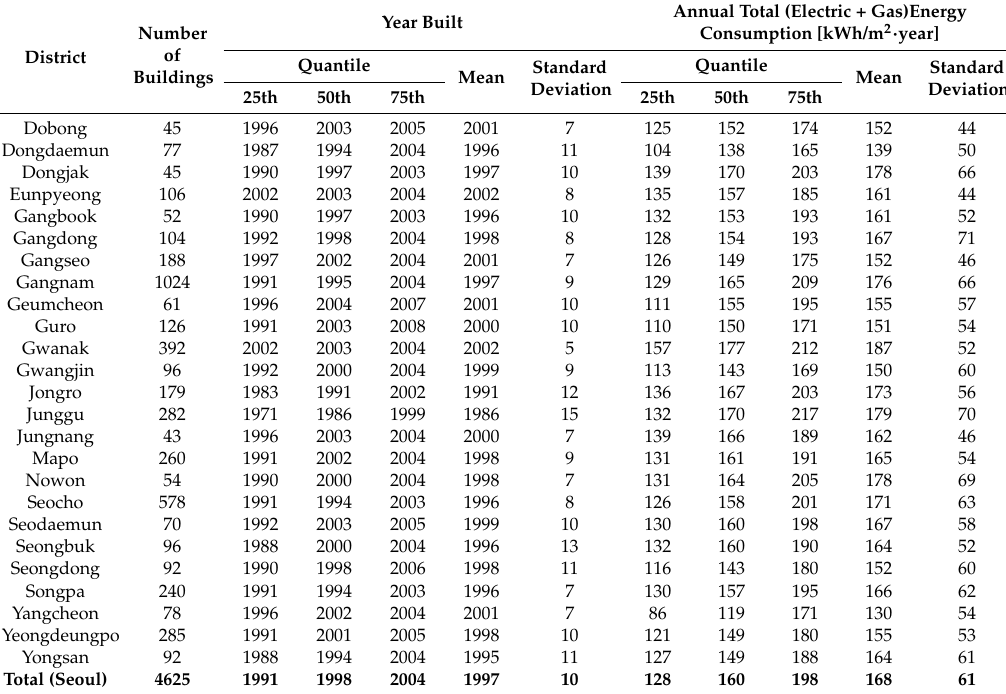
Table 1. Descriptive statistics of year built and annual energy consumption of 4625 office buildings in the 25 districts of Seoul, Korea, in